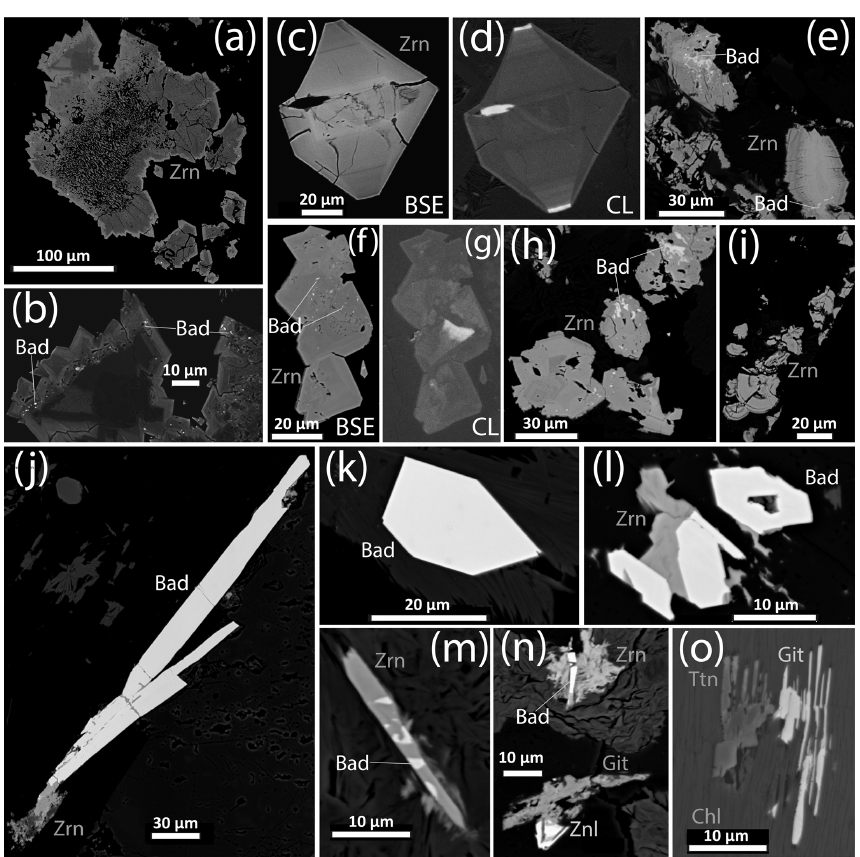
Figure 5. BSE and CL images of accessory minerals in CSMS. (a–i) Different habits of zircon in sample S2C, most of them with baddeleyite inclusions. (j–l) Euhedral baddeleyite with and without zircon intergrowth. (m) Relict baddeleyite within zircon pseudomorph, with a feather- like zircon corona. (n) Baddeleyite and zirconolite, intergrown with zircon and gittinsite. (o) Gittinsite–titanite intergrowth within